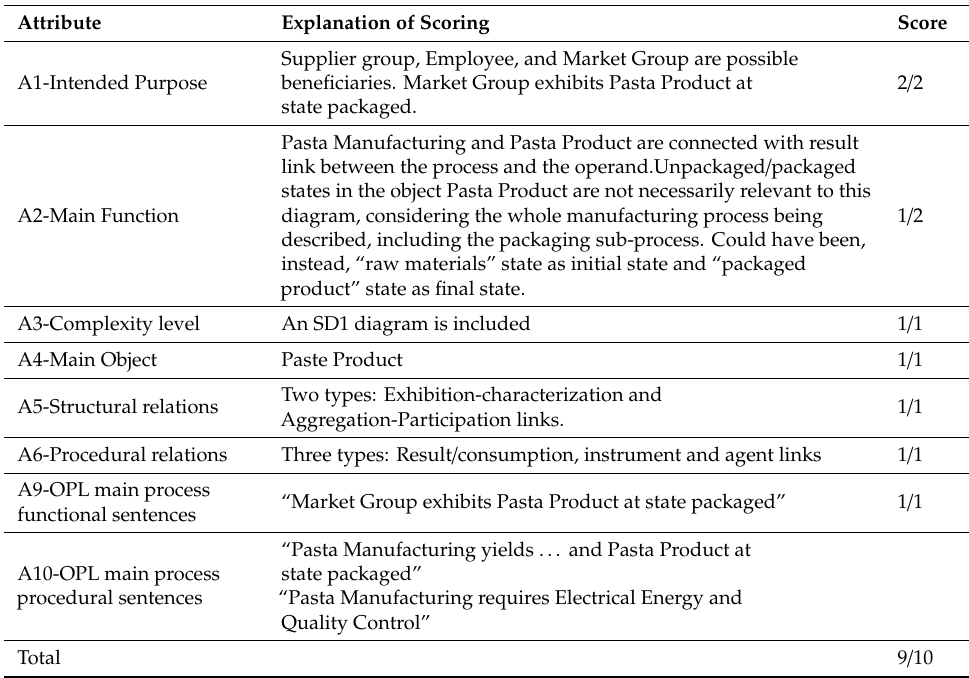
Table 7. Explanation of participant #722122205 modeling